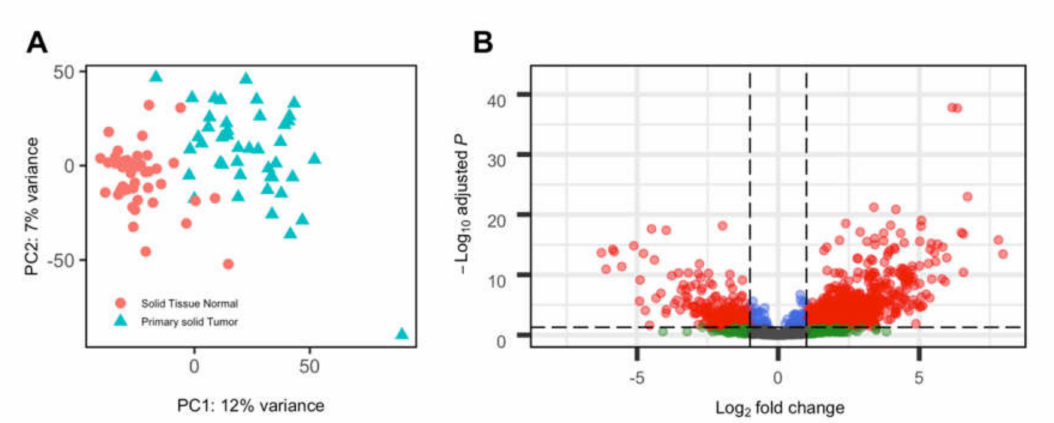
Figure 1. Human endogenous retrovirus (HERV) expression in head and neck squamous cell carcinoma (HNSCC) tumor and paired normal samples. ( A ) Principal component analysis, with shape and color indicating tumor vs normal tissue. ( B ) Volcano plot of differential expression between tumor and normal tissue. Positive log-fold change indicates higher expression in tumor tissue. The dashed horizontal line indicates adjusted p -value threshold of 0.05. The dashed vertical line indicates a log2-fold change of +/ − 1.5. Out of 3520 identified HERVs, 1078 were di ff erentially expressed between tumor and normal samples. Of these, the majority (802) were expressed at a higher level in tumor tissue compared to normal tissue (Figure